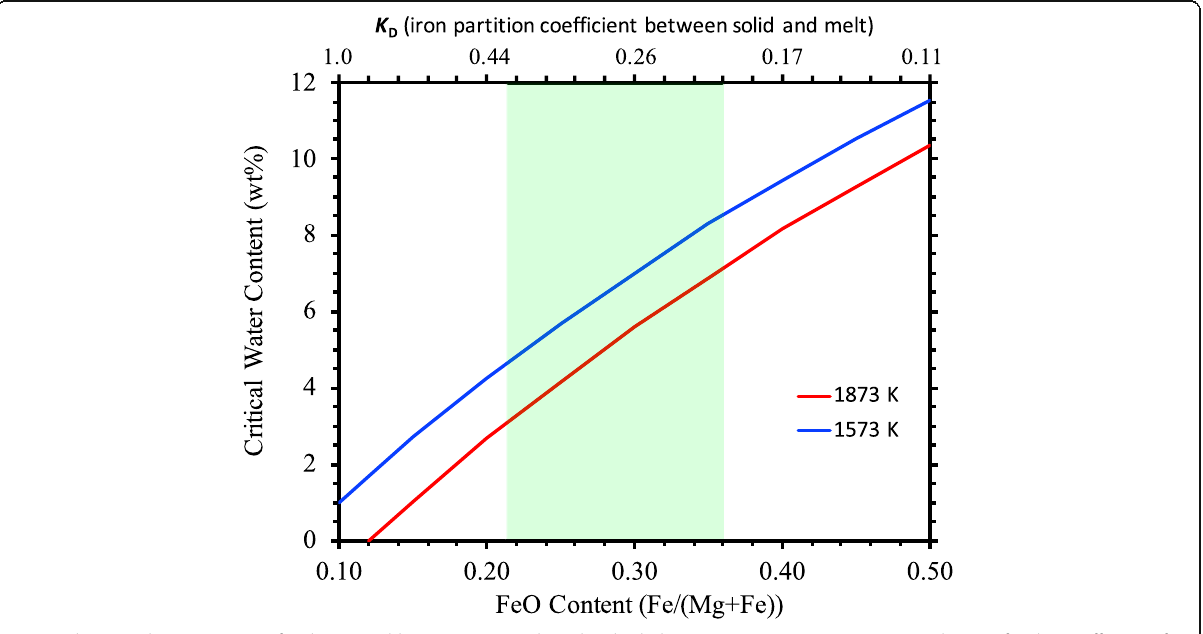
Fig. 5 The critical water content for the neutral buoyancy at 410 km. The shaded region represents an experimental range for the coefficient of iron portioning between the melt and mineral ( K D ¼ ð FeO = MgO Þ mineral ð ). Results may depend also on the concentrations of other components such as FeO = MgO Þ melt is insensitive to temperature (Mibe et al. 2006), but K 2 O and CO 2 (Jing and Karato 2012). According an experimental study K D ¼ ð FeO = MgO Þ olivine ð FeO = MgO Þ melt water content in the melt increases with decreasing temperature. This makes melts buoyant at relatively low